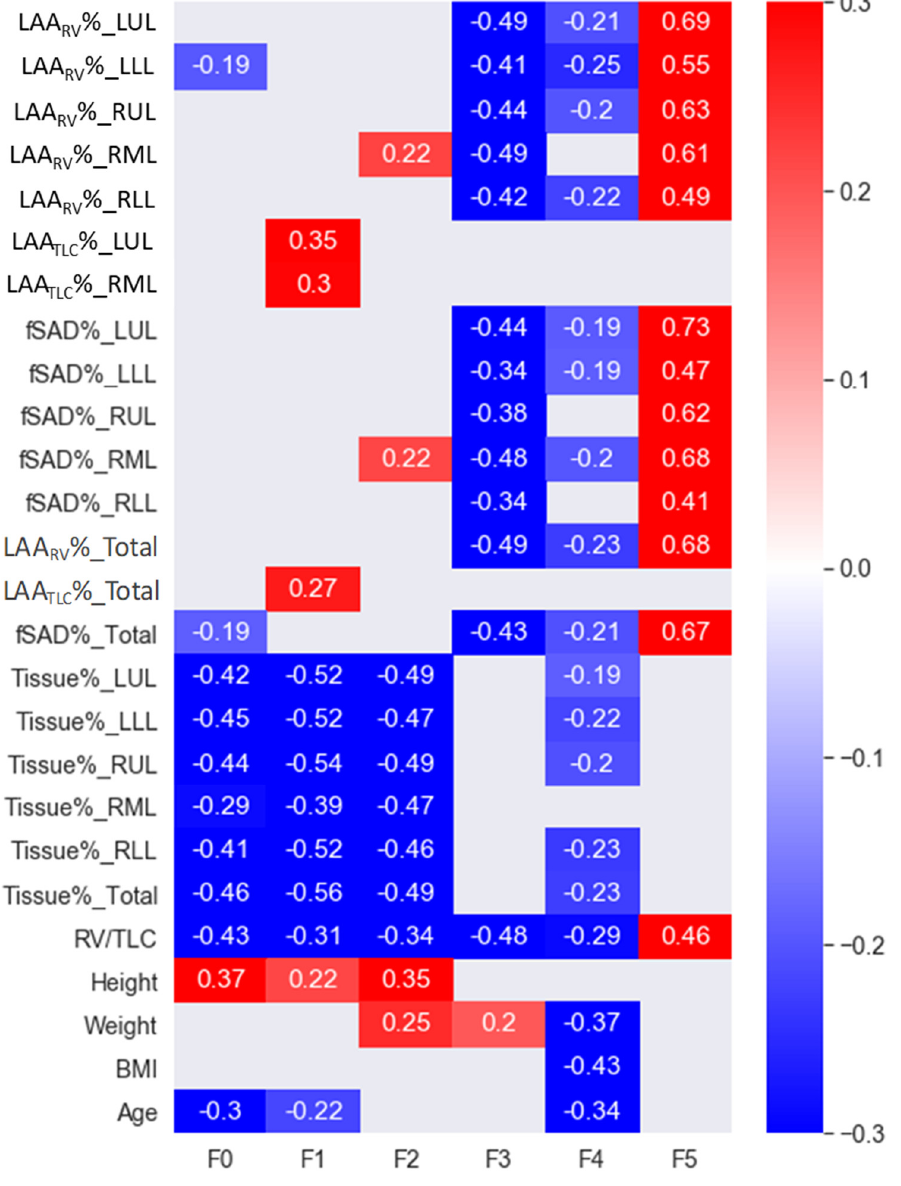
Figure 7. Pearson’s correlations between factors and common clinical data and imaging-based variables. Only correlations with p values of less than 0.05 are shown in the figure.